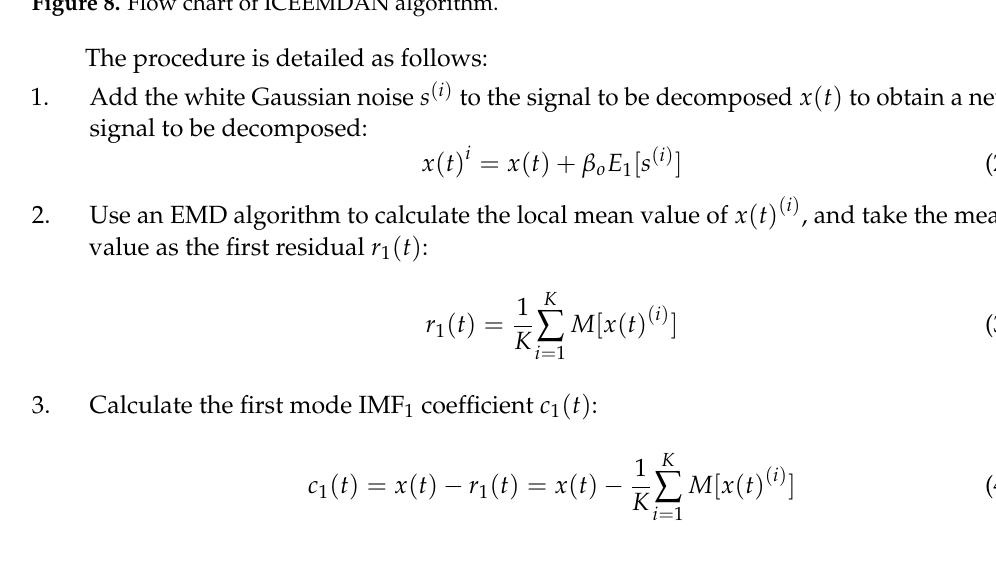
Figure 8. Flow chart of ICEEMDAN algorithm.